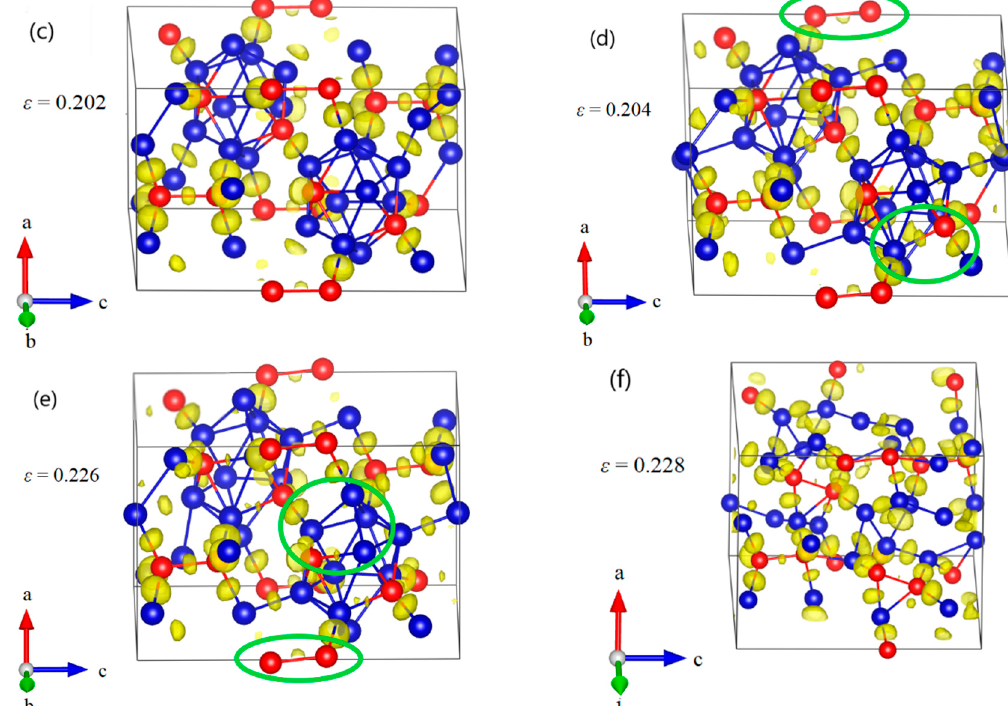
Figure 6. The structural changes and ELF at various critical strains for B 10 C 2P –CC structure under c axis uniaxial compression: ( a ) the initial structure; ( b ) the structure at ε = 0.20 relating to the maximum stress; ( c ) the structure at ε = 0.202 before the first stress drop, where the icosahedra are intact without breaking any bonds; ( d ) the structure at ε = 0.204 after the first stress drop, where the B–C P bonds within icosahedra are broken; ( e ) the structure at ε = 0.226 before structural failure; ( f ) the structure at ε = 0.228 where the structure fails because of the fully destruction of icosahedra (Blue = B atoms; red = C atoms).